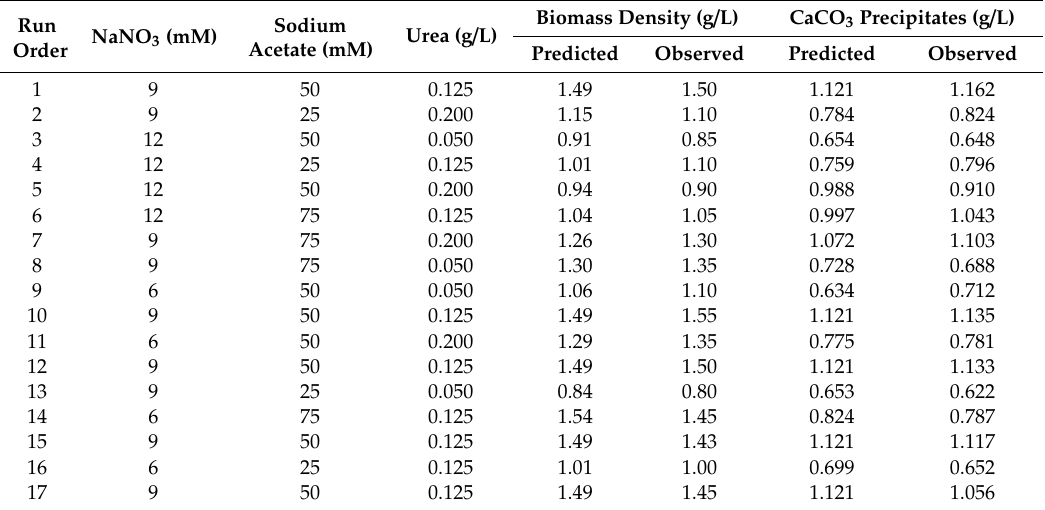
Table 4. Three-factor Box–Behnken Design (BBD) with factorial levels shown in actual values as well as predicted and observed biomass density and CaCO 3 precipitates